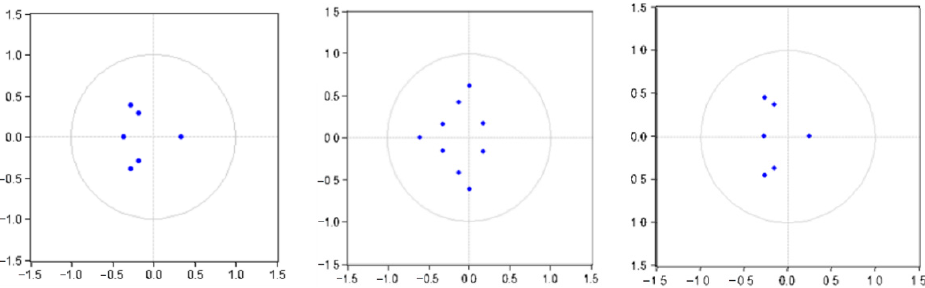
Figure 3. Impulse response of Shanghai copper to New York copper yield. Figure 4. Impulse response of Shanghai copper to London copper yield. Figure 3 shows that the initial impact of New York copper on the futures price of Shanghai copper is 0.53. The impact rapidly rises to the peak in the second period and then decreases rapidly. Subsequently, it remains horizontal from the third to the seventh period, and then decreases slowly until it reaches 0. Figure 4 indicates that the initial impact of London copper on the futures price of Shanghai copper is 0.19, and the effect decreases slowly and continuously. From the fourth period onward, the impact effect is not significant, gradually converging to 0.